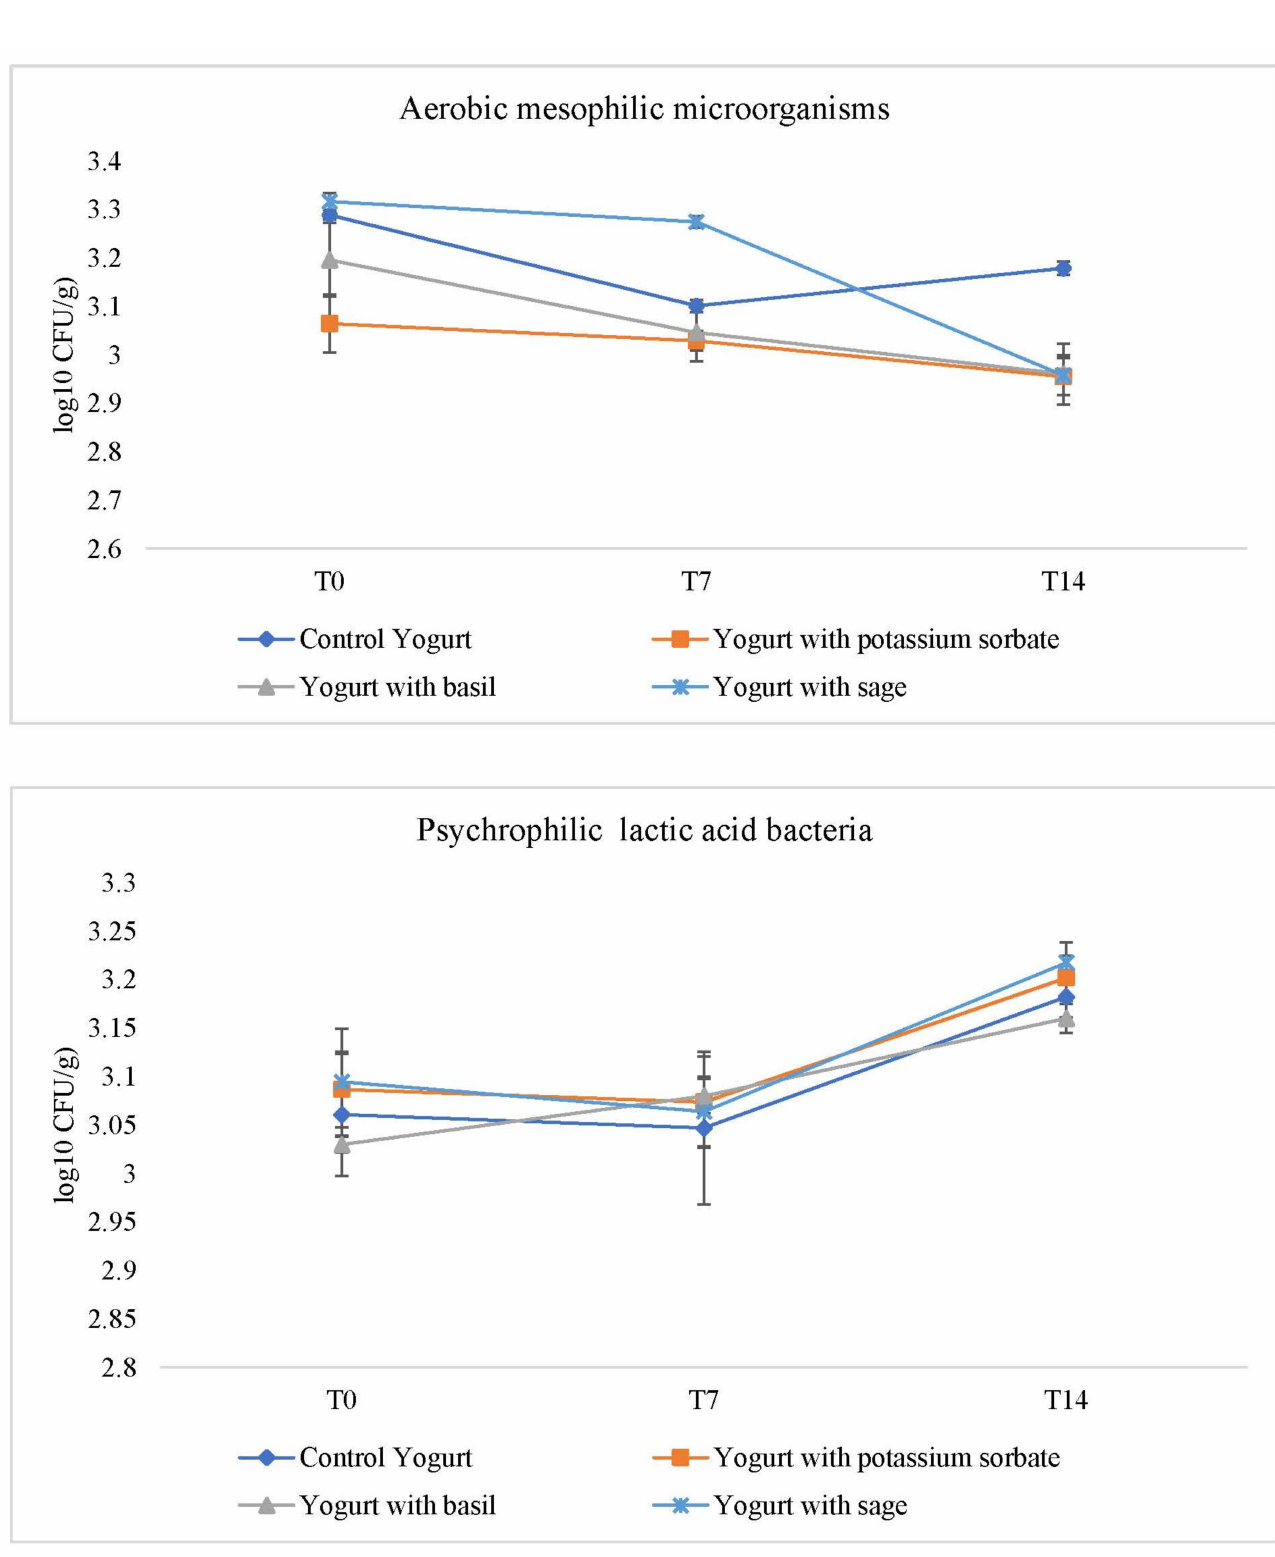
Figure 1. Aerobic mesophilic (top) and psychrophilic lactic acid bacteria (bottom) microbial load over 14